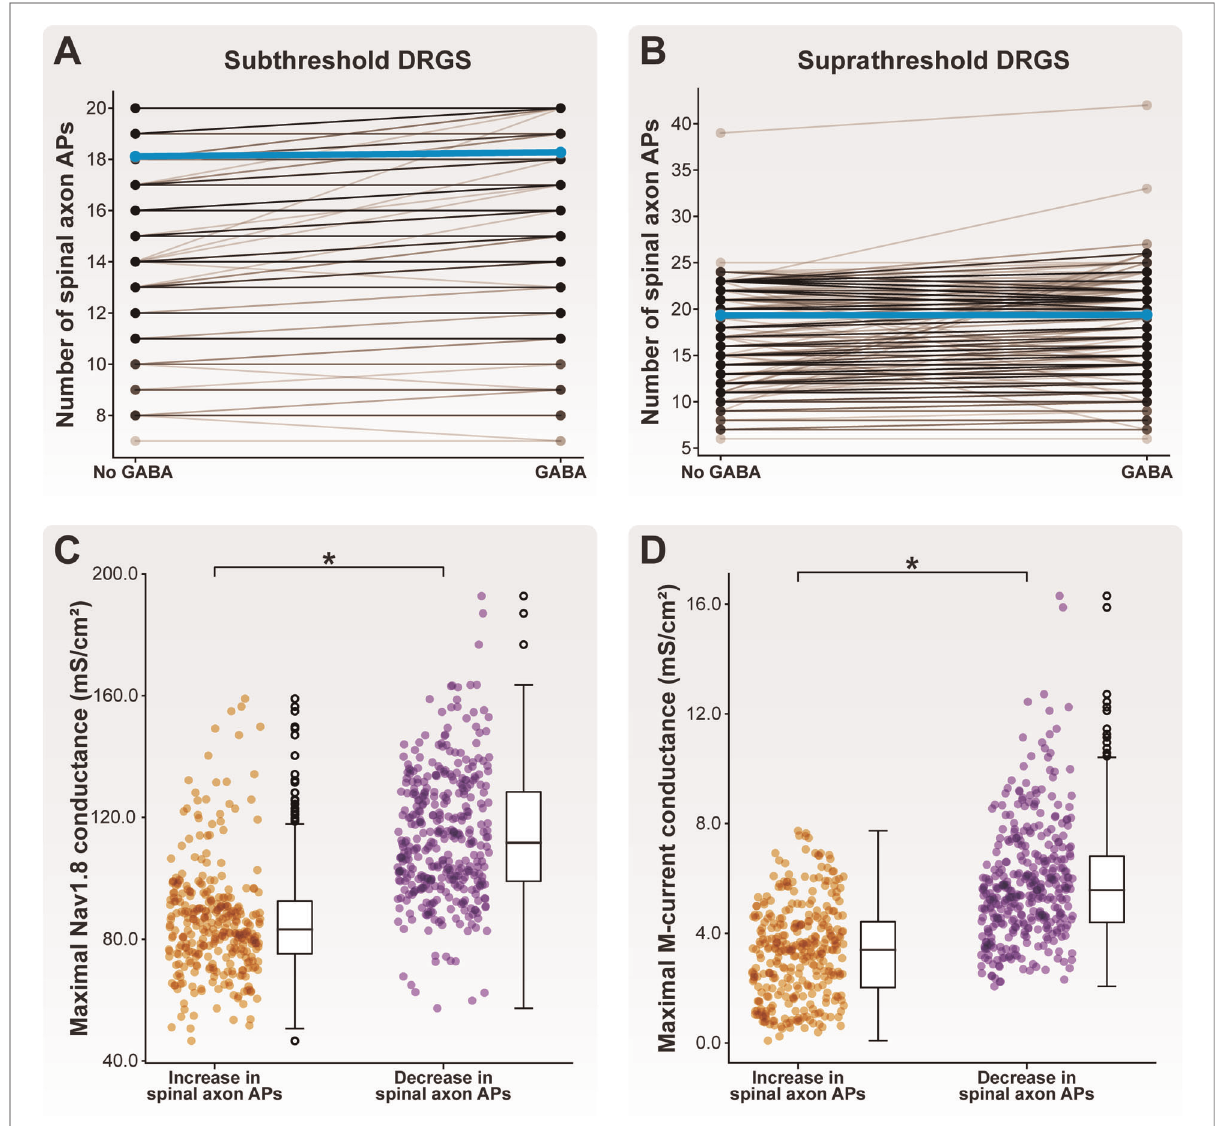
FIGURE 10 Effect of GABA on AP propagation through the T-junction during tonic DRGS. Each brown line corresponds to an individual model C-neuron, and each blue line corresponds to the model population average. Including a somatic GABA conductance activated 1 ms after the DRGS pulse caused some model C-neurons to increase the number of APs propagating through the T-junction while other model C-neurons decreased the number of APs during ( A ) subthreshold and ( B ) suprathreshold DRGS. Model C-neurons which decreased the number of APs entering their spinal axons had signi fi cantly higher maximal ( C ) Nav1.8 and ( D ) M-current